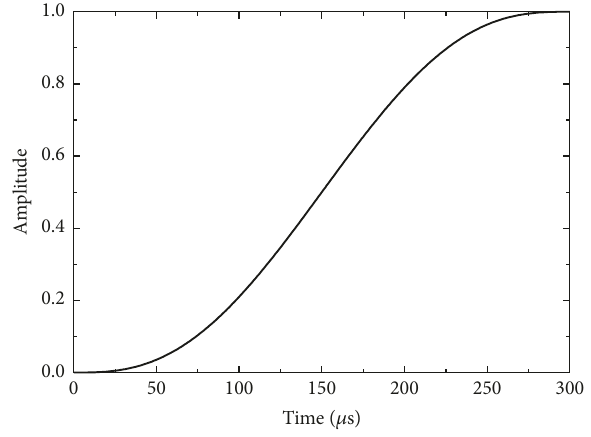
Figure 2: Loading time-history curve.